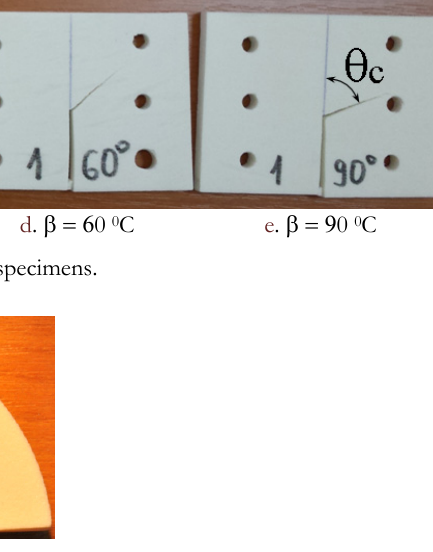
Figure 6 : Measurement of crack initiation